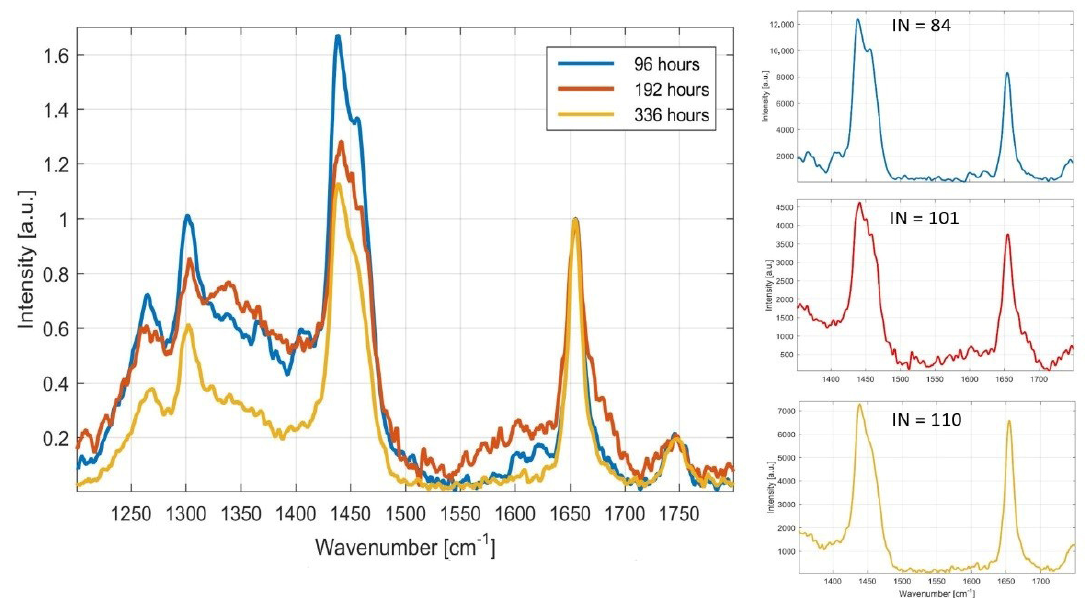
Figure 7. Changes of unsaturation of FA during the cultivation of M. pulcherrima 149 for the C/N ratio 97. Legend: (1) 96 h of cultivation (96 h, blue trace), (2) 192 h of cultivation (192 h, red trace) and (3) 336 h of cultivation (336 h, yellow trace). The main spectra are normalized for clarity (peak at 1656 cm − 1 ). Three insets on the right show details for each spectrum, so that intensities and, in turn, ratios of both peaks can be compared. Calculated iodine numbers (INs) are indicated according to the equation at Figure 10. Figure shows that, with increasing cultivation time, unsaturation of fatty acids is also increased.